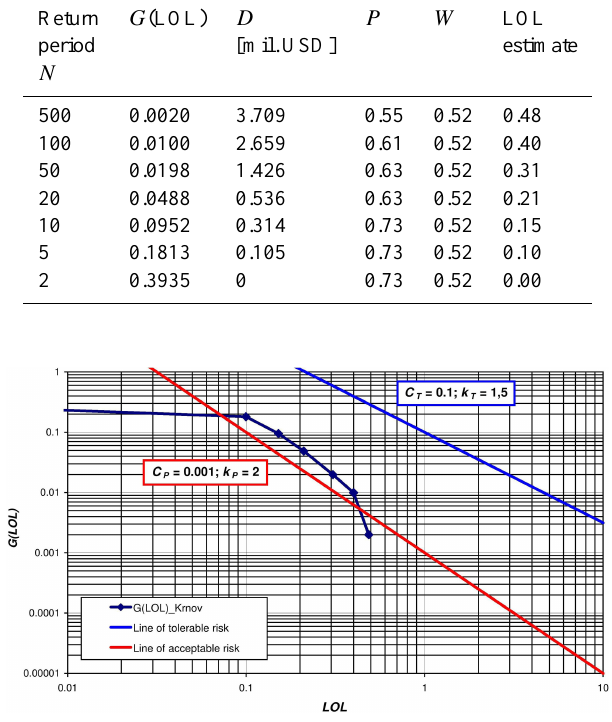
Figure 2. F–N curve for the Krnov